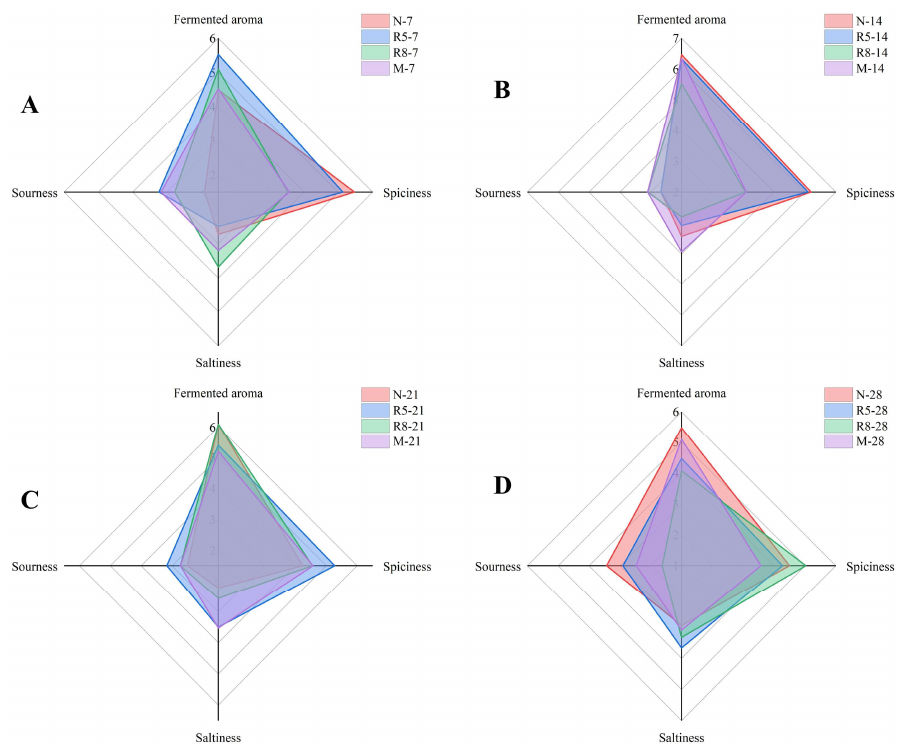
Figure 10. Comparison of radar charts for sensory evaluation data of pickles with different fermented times. ( A – D ) Pickle samples fermented for 7, 14, 21, and 28 days, respectively.